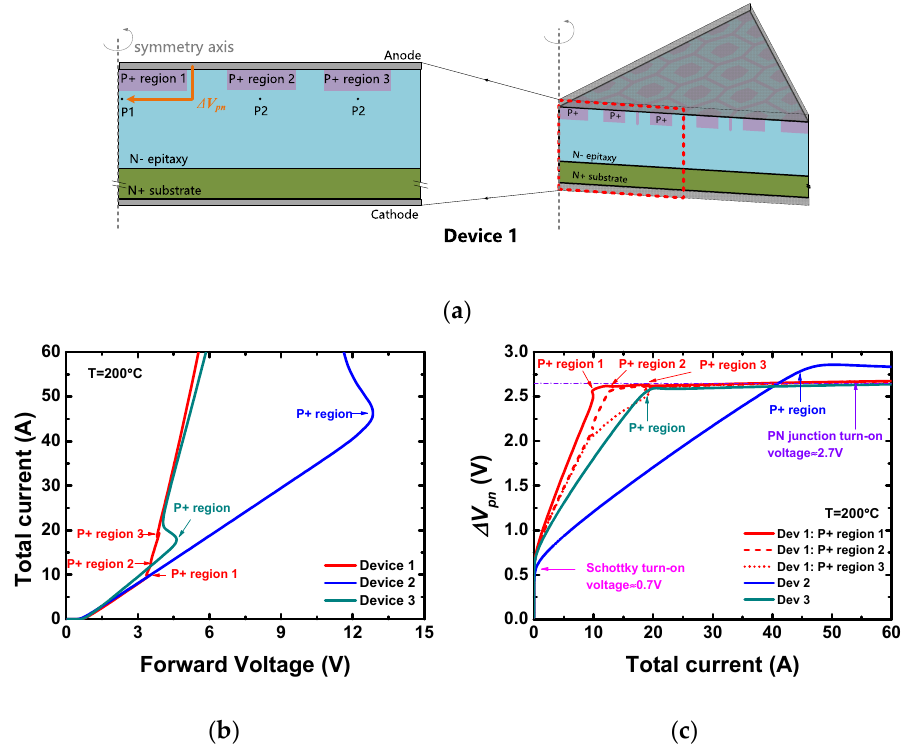
Figure 6. ( a ) The schematic diagram of the method of calculating the voltage drop of a PN junction in a cell of the MPS diode, showing Device 1 as an example. ( b ) The forward characteristics and ( c ) the dependence of the PN junction voltage drop on the total current ( ∆ V pn -I curves) of the three devices at T = 200 ◦ C. The points corresponding to the activation of the PN junctions of each device are